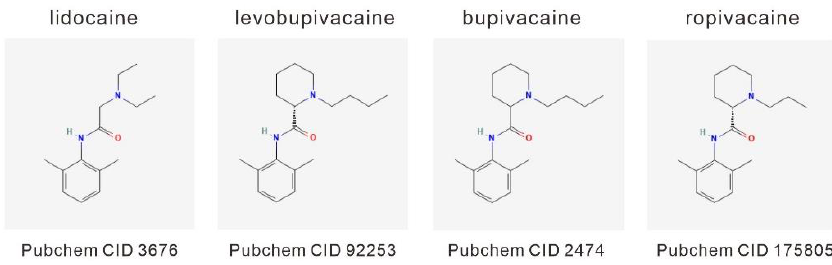
Figure 1. A diagram of the local anesthetics: lidocaine, levobupivacaine, bupivacaine, and ropivacaine. Compound ID (CID) is the identifier from a database of chemical molecules and their activities of biological assays in PubChem.